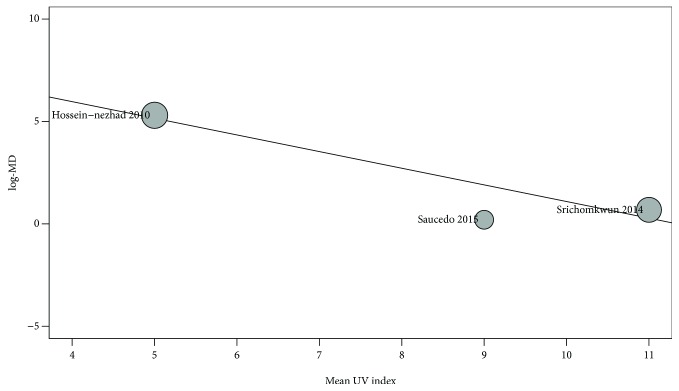
Metaregression on the pooled mean difference for tOC and the mean UV index.